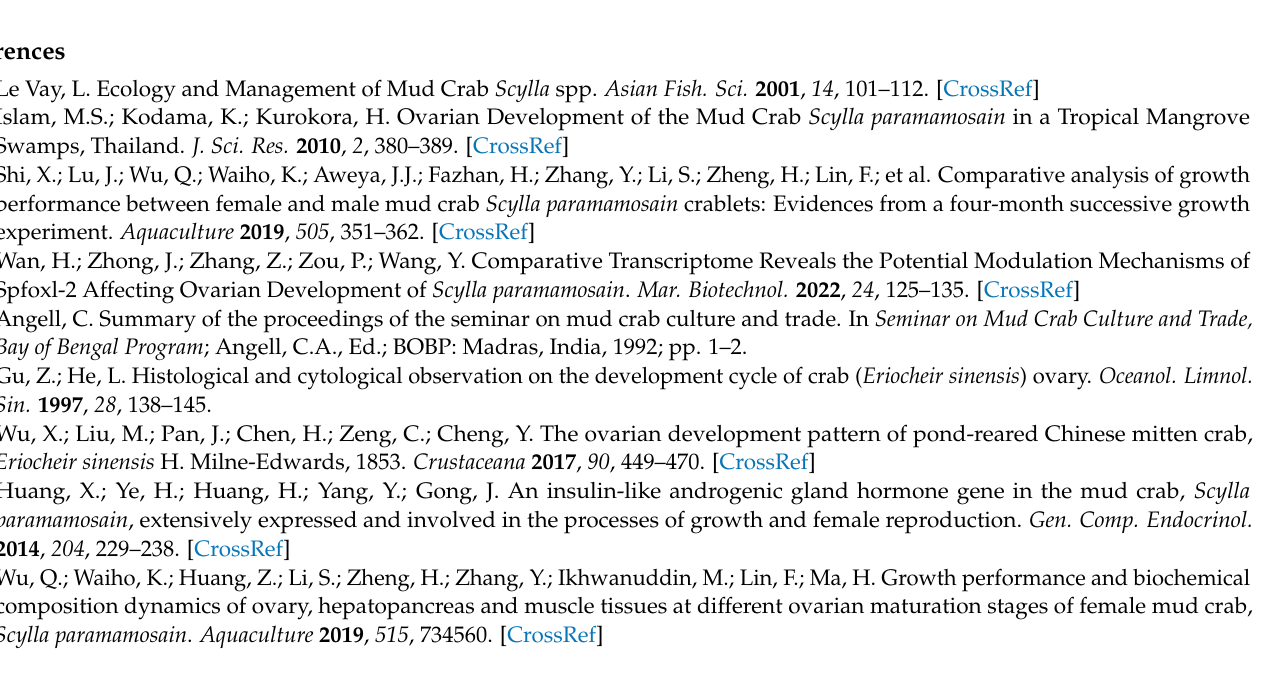
Table S2: Raw data statistics table; Table S3: Clean data statistics; Table S4: Information of eggNOG functional categories; Table S5: Information of functional proteins in PPI